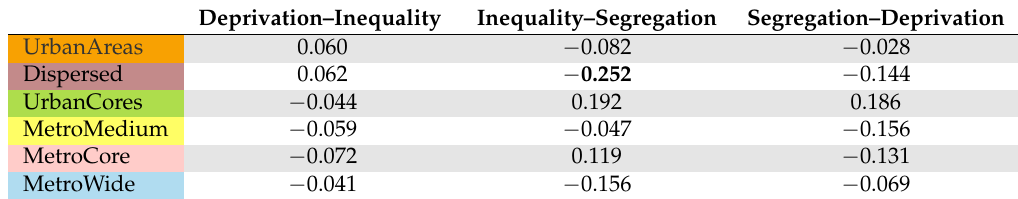
Table 2. Spearman correlations between three census indicators for the centroid definition of all the six classes.